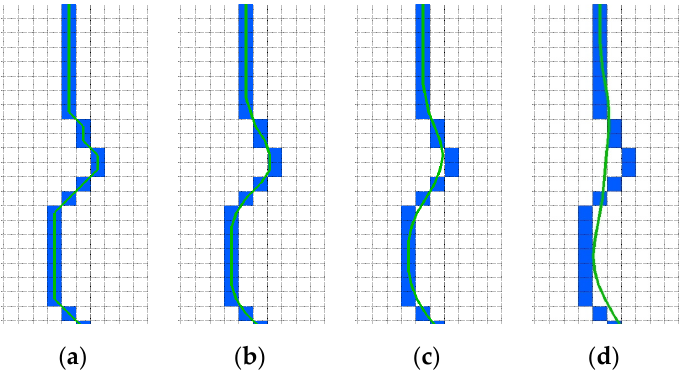
Figure 8. Stream smoothing with: ( a ) zero radius; ( b ) radius 1; ( c ) radius 2; and ( d ) radius 5.